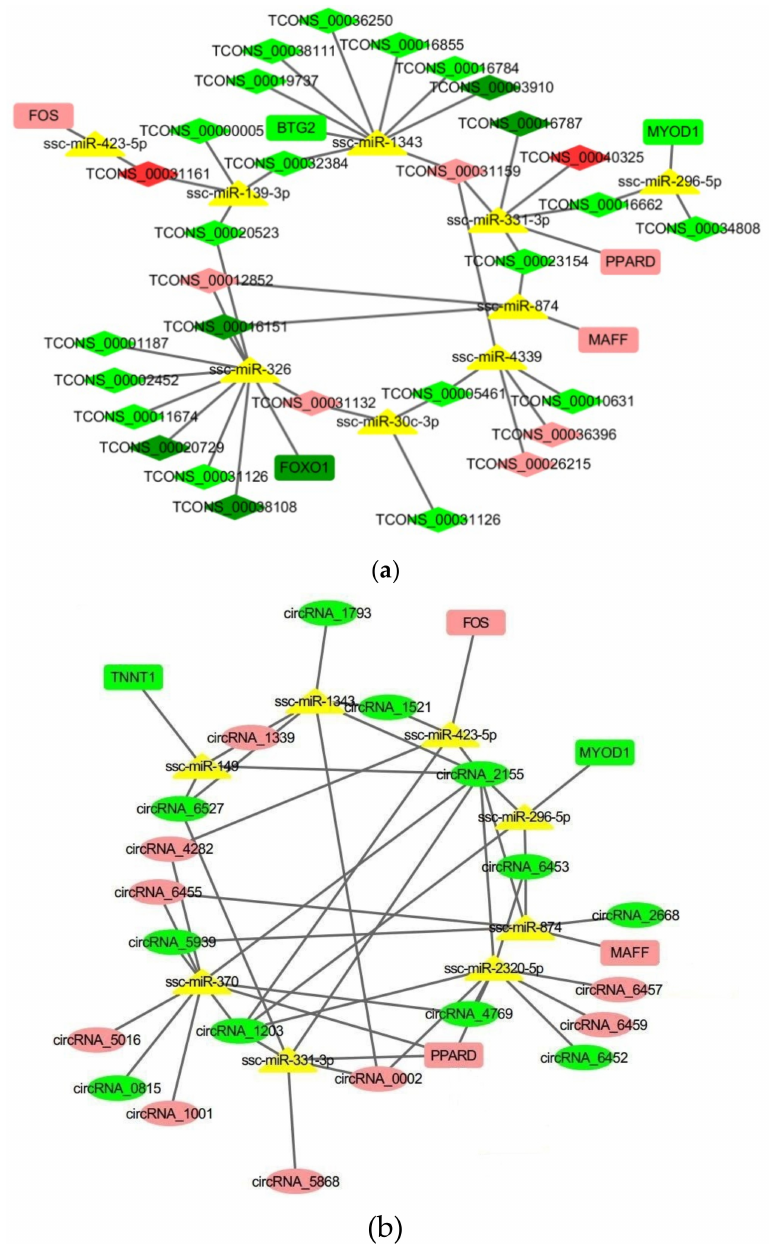
Figure 4. Network analysis of lncRNA-miRNA-mRNA ( a ) and circRNA-miRNA-mRNA ( b ). Square nodes represent mRNAs; triangular nodes represent miRNAs; diamond nodes represent lncRNAs; and circular nodes represent circRNAs. Red nodes represent the up-regulated, and the green ones represent the down-regulated transcripts, in Huainan (HN) and Duroc × (Landrace × Yorkshire) (DLY) pigs (a deeper color represents a higher difference in the expressional level between different breeds), and the yellow nodes represent the undetected